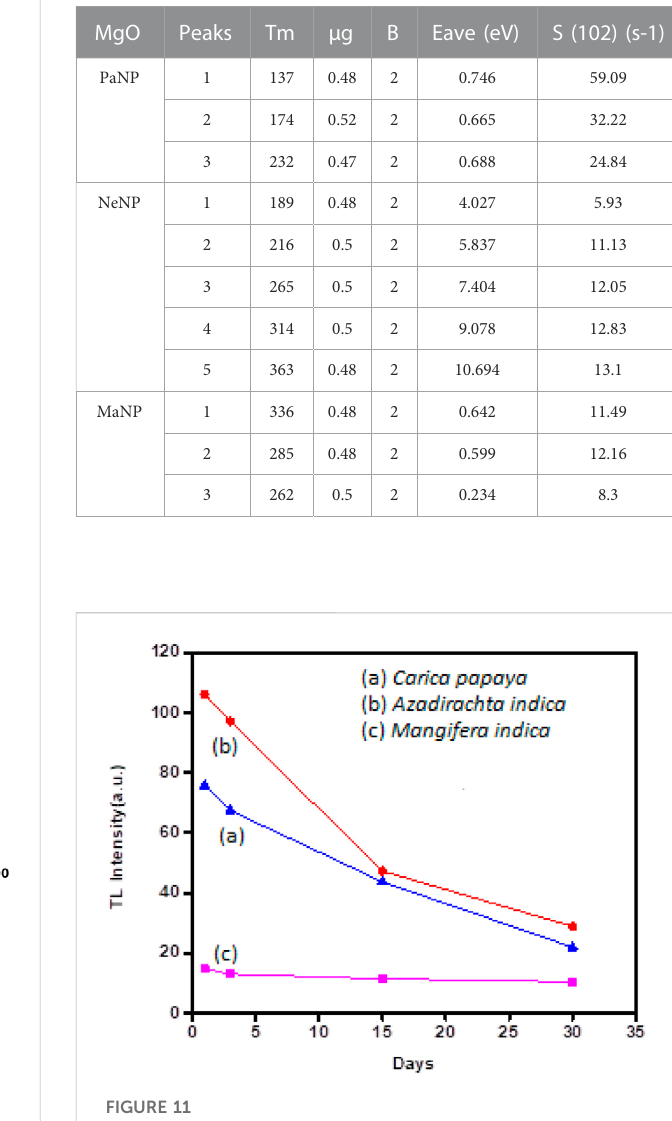
FIGURE 11 Fading characteristics shown in PaNP, NeNP, and